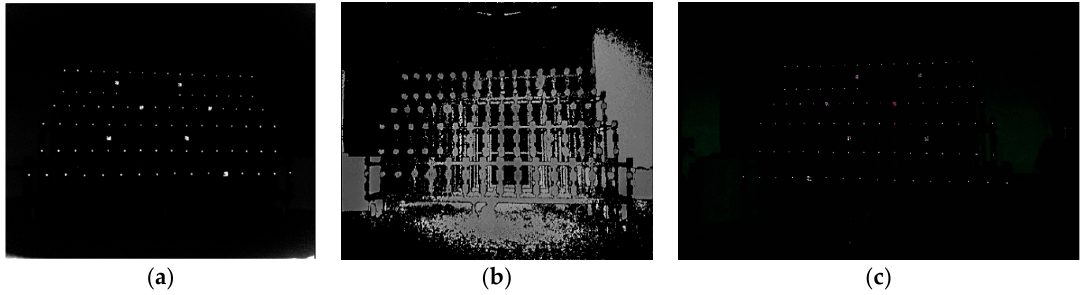
Figure 4. Images captured in a 3D control field: ( a ) infrared image; ( b ) depth image; ( c ) RGB image.